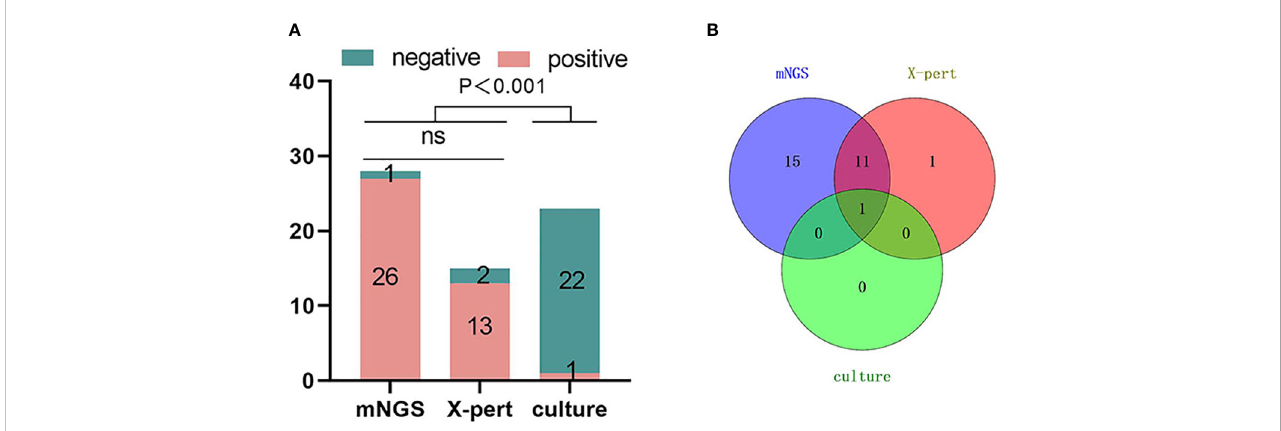
FIGURE 5 Comparison of mNGS, X-pert and culture positive rates for the detection of Mycobacterium tuberculosis in spinal tuberculosis focal tissue samples. The number of positive samples detected by the three detection methods showed in (A) that the positive rate of mNGS was higher than that of X-pert, but there was no statistical difference. The positive rate of mNGS and X-Pert was higher than that of culture, and the difference was statistically signi fi cant (P < 0.001). (B) Overlapping Venn diagram of samples positive for MTB by the three tests. mNGS, metagenomic next-generation sequencing; X-pert, the X-